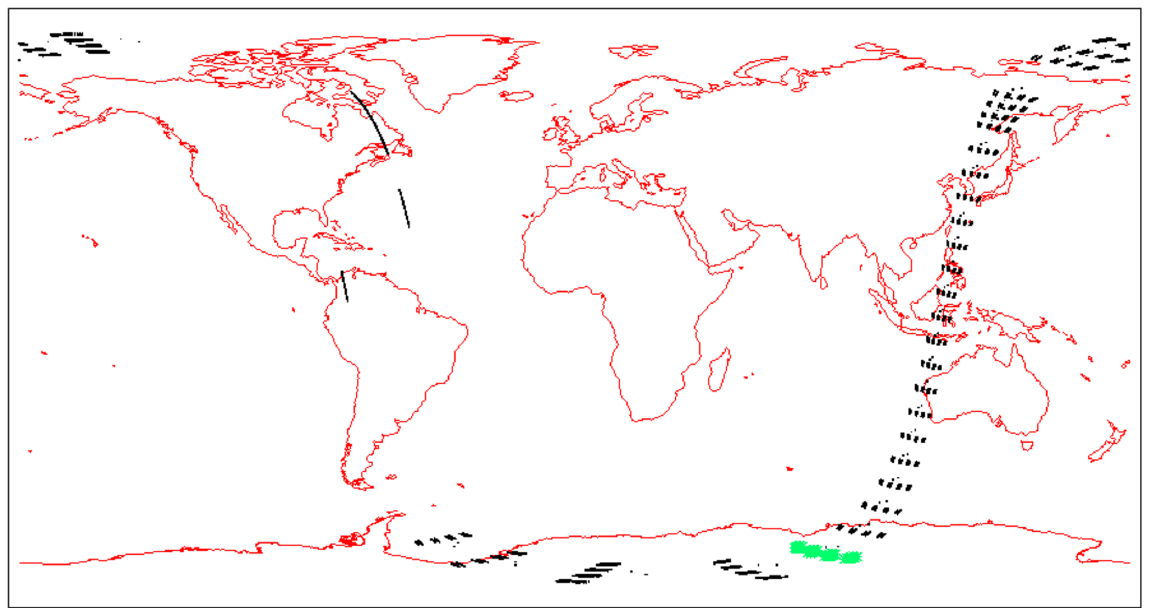
Figure F5. Geographic positions of SCIAMACHY LOS tangent points at the limb (by groups of four) for Envisat orbit no. 25293, starting on 1 January 2007 at 01:12UT. The green points are the locations of the limb spectra which are compared with our theoretical derivation in Sect.